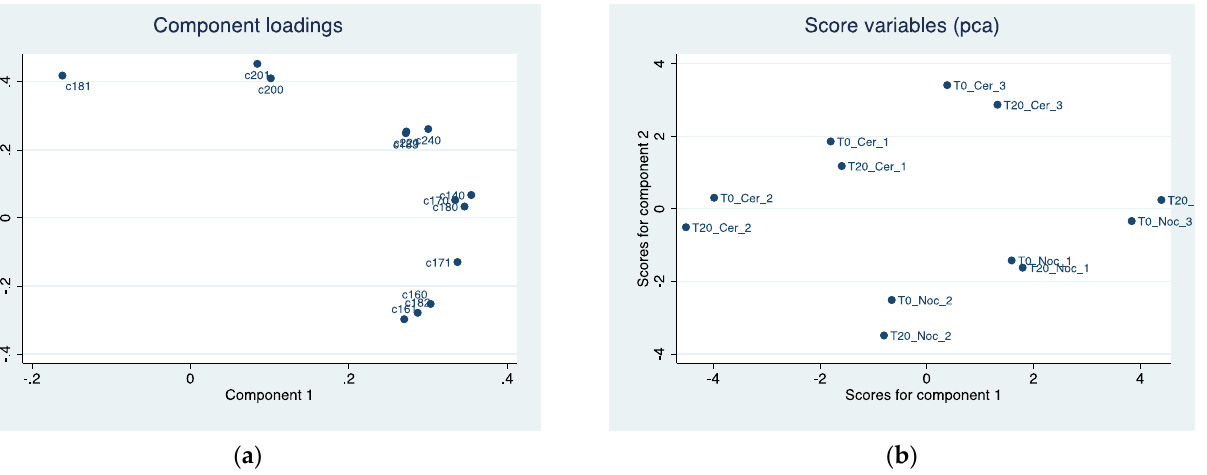
Figure 7. ( a ) Component loadings of fatty acid components in two EVOO cultivars by different malaxation methods (T0 and T20). First two principal component (Component 1 x -axis, Component 2 y -axis) analysis (PCA). ( b ) Predicted scores after PCA obtained as linear combination of the observation data by using eigenvector of component 1 ( x -axis) and eigenvector of component 2 ( y -axis). Table 9. Component loadings of the fatty acids of EVOOs .